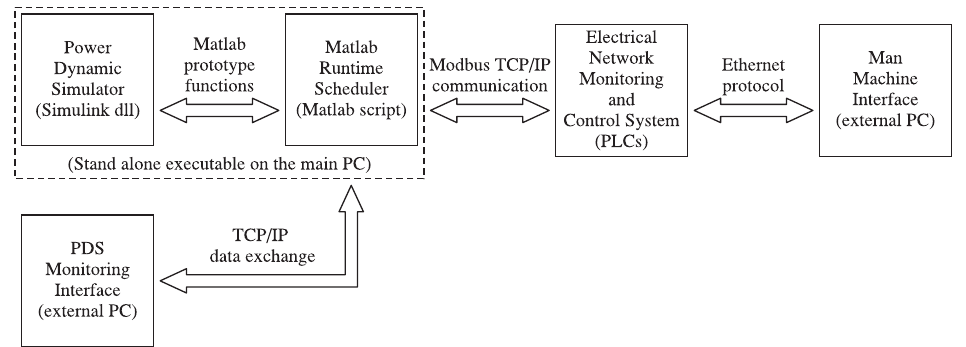
Figure 4. Block diagram and information exchange among subsystems. dll, dynamic-link library; PDS, power dynamic